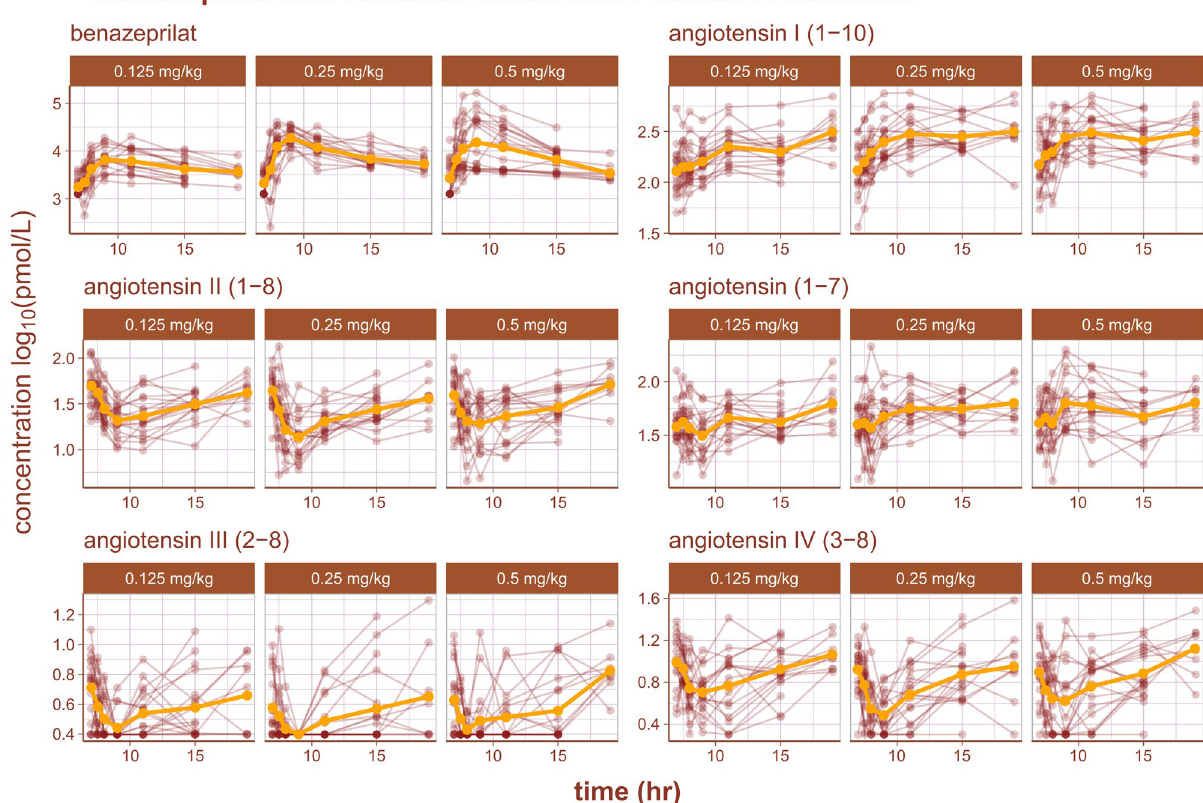
Figure 2. RAAS biomarkers pharmacodynamics. An overview of the plasma time-course of several RAAS biomarkers as well as benazepril’s active metabolite, benazeprilat. Each subject’s time-course is indicated with a red line and points. The golden curve is the mean time-course